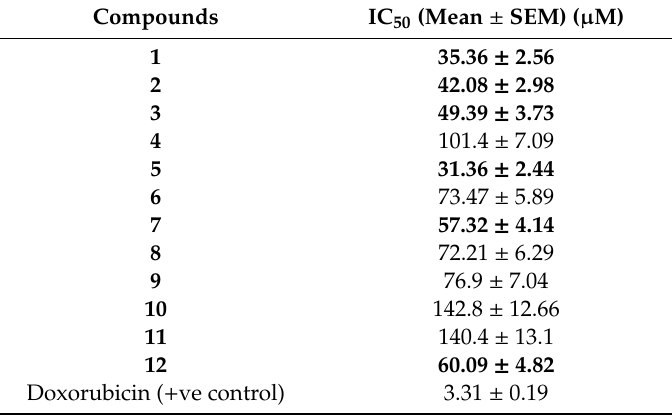
Table 1. The calculated IC 50 values of compounds 1 – 12 in MDA-MB-231 breast cancer cell